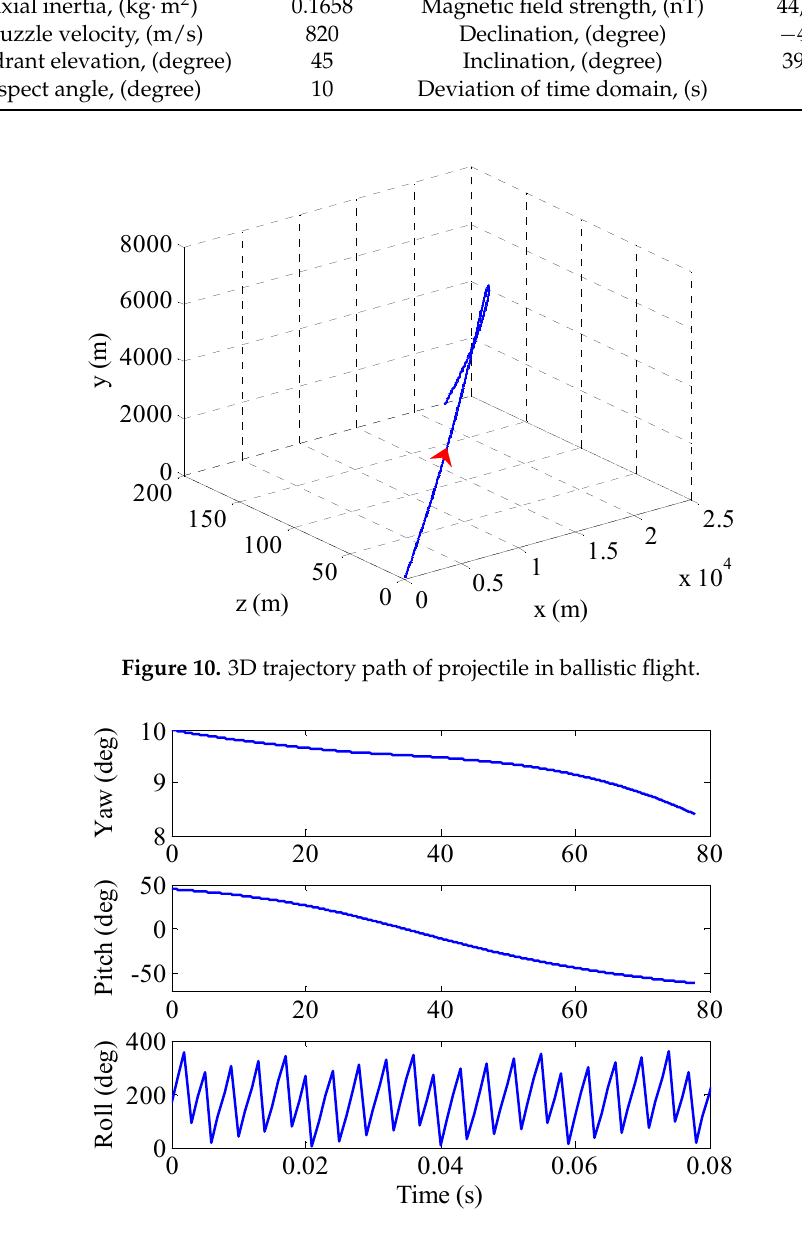
Figure 11. Euler angles of projectile in ballistic flight.